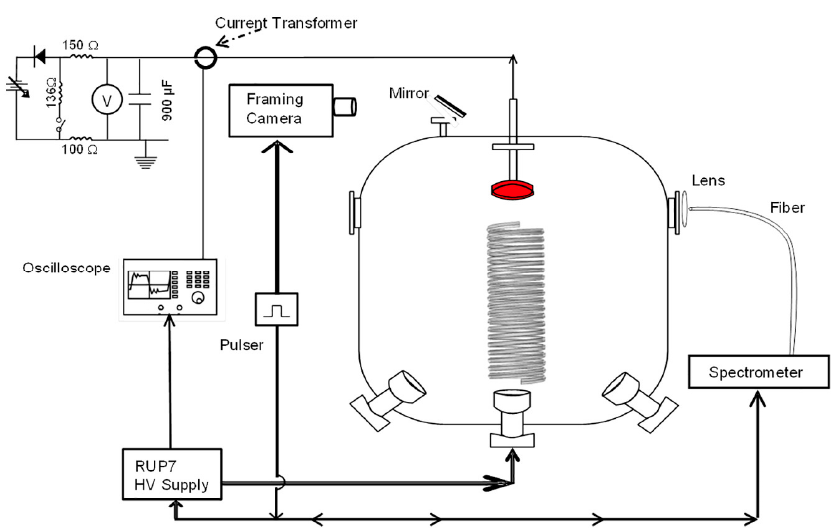
Figure 9. Experimental unit high power impulse magnetron sputtering (HiPIMS) deposition system showing the additional solenoidal coil. Reproduced from [100] with permission. Copyright 2019 Elsevier.